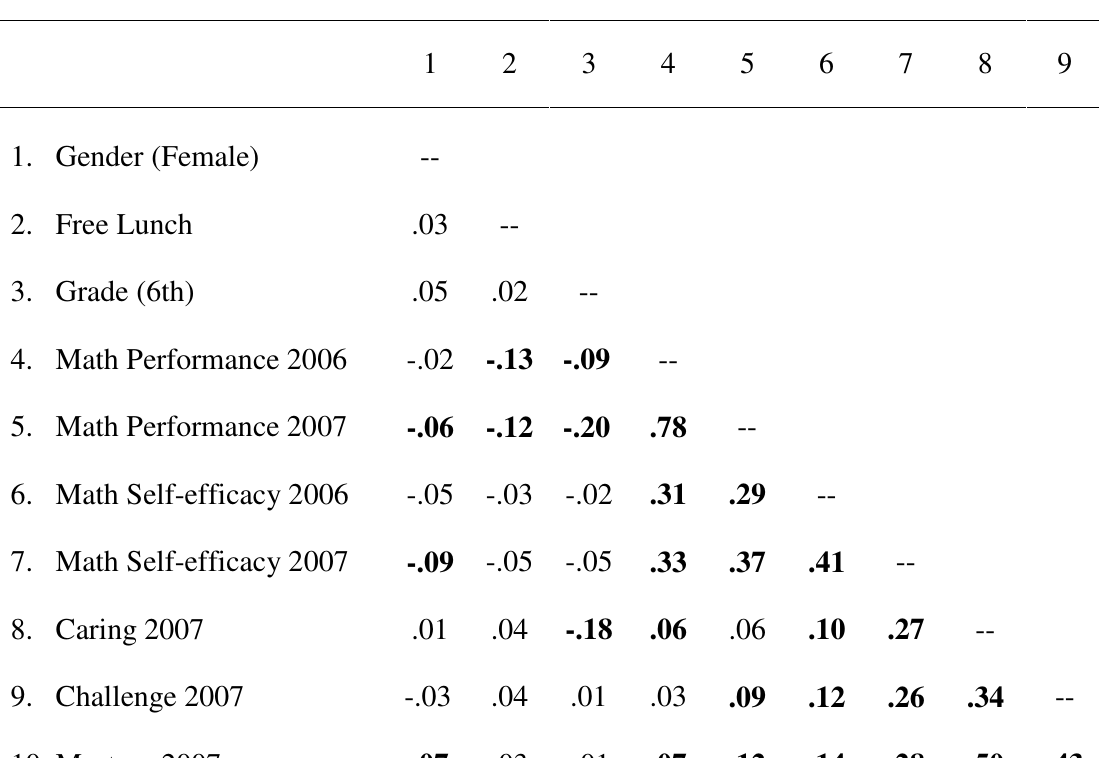
Bivariate Correlations Between Study